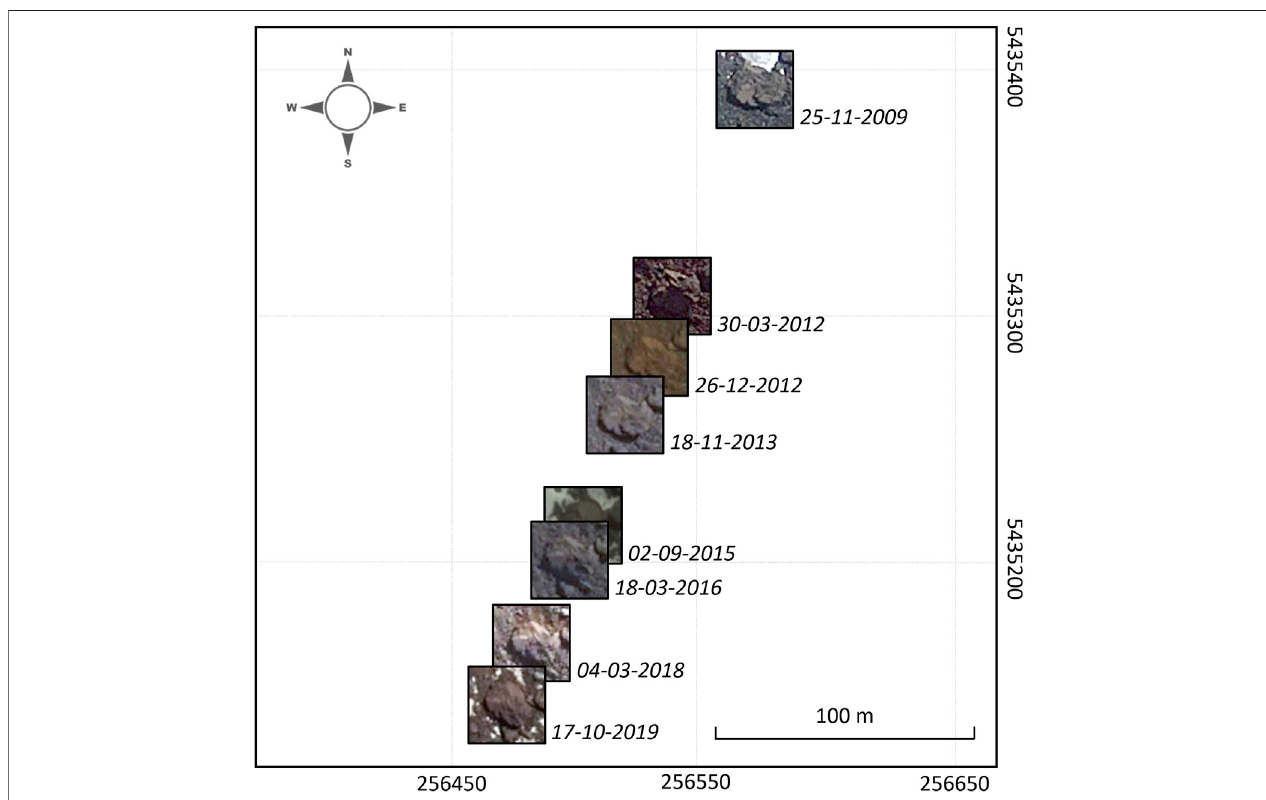
FIGURE 2 | Tracking of a boulder located at the surface of the Verde glacier. Each dated square represent the same boulder on distinct cropped images from GoogleEarth.Redarrowon Figure6A indicatesthepathofthepresentboulder.Coordinatesinmeters,universaltransversemercator(UTM)projection,zone19,World Geodetic System (WGS84)